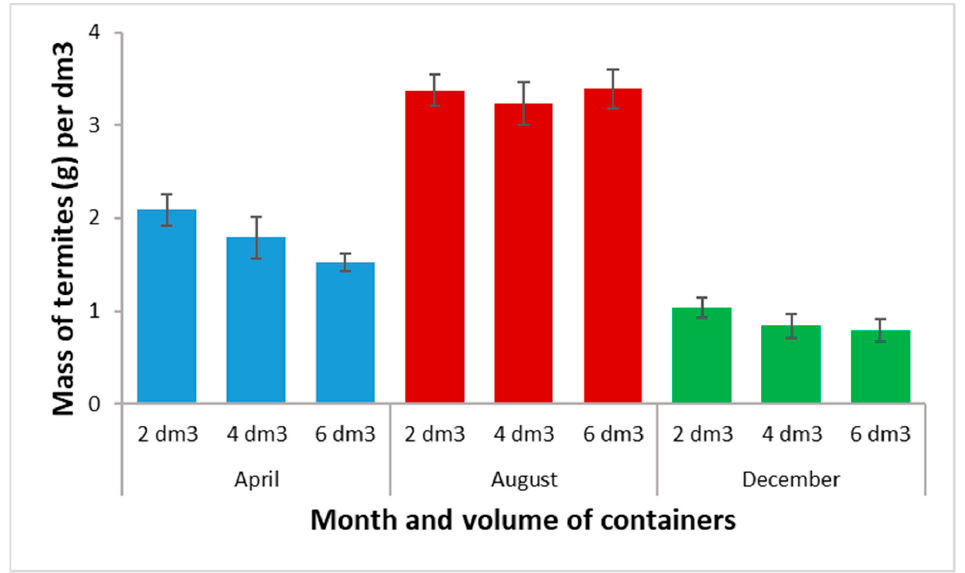
Figure 8. Average masses of termites harvested per container and per dm 3 of volume, according to the volume of containers. In the same month, there was no significant difference between containers’ volumes at the 5% level. Error bars represent standard errors.